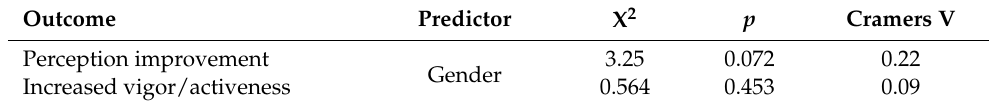
Table 5. Association between Gender predictor and certain POSITIVE effects 24 h after CAF ingestion. Outcome